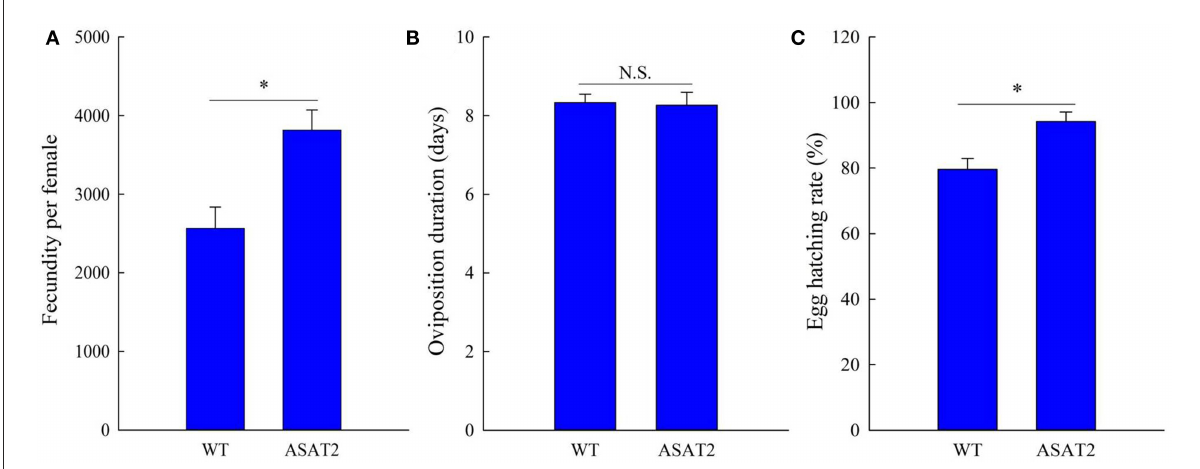
FIGURE4 Fecundity (A) , oviposition duration (B) , and egg hatching rate (C) of the F 0 generation of S. litura on WT and ASAT2 plants of N. benthamiana . Values are presented as means ± SE. Asterisks above error bars indicate significant differences ( P < 0.05), and n.s. indicates not significant ( P >